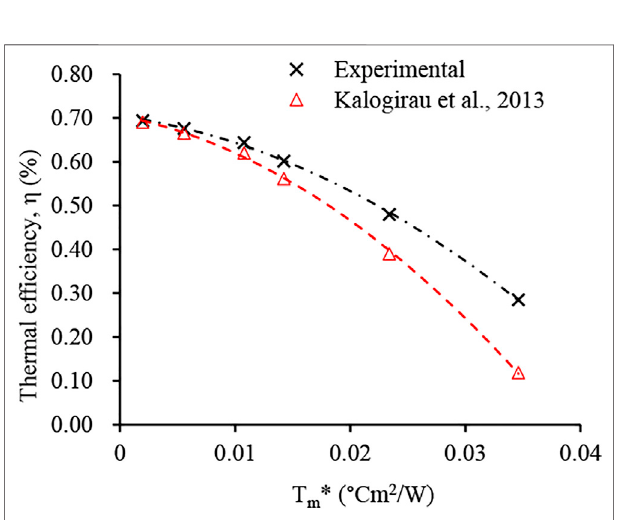
Frontiers in Energy Research |